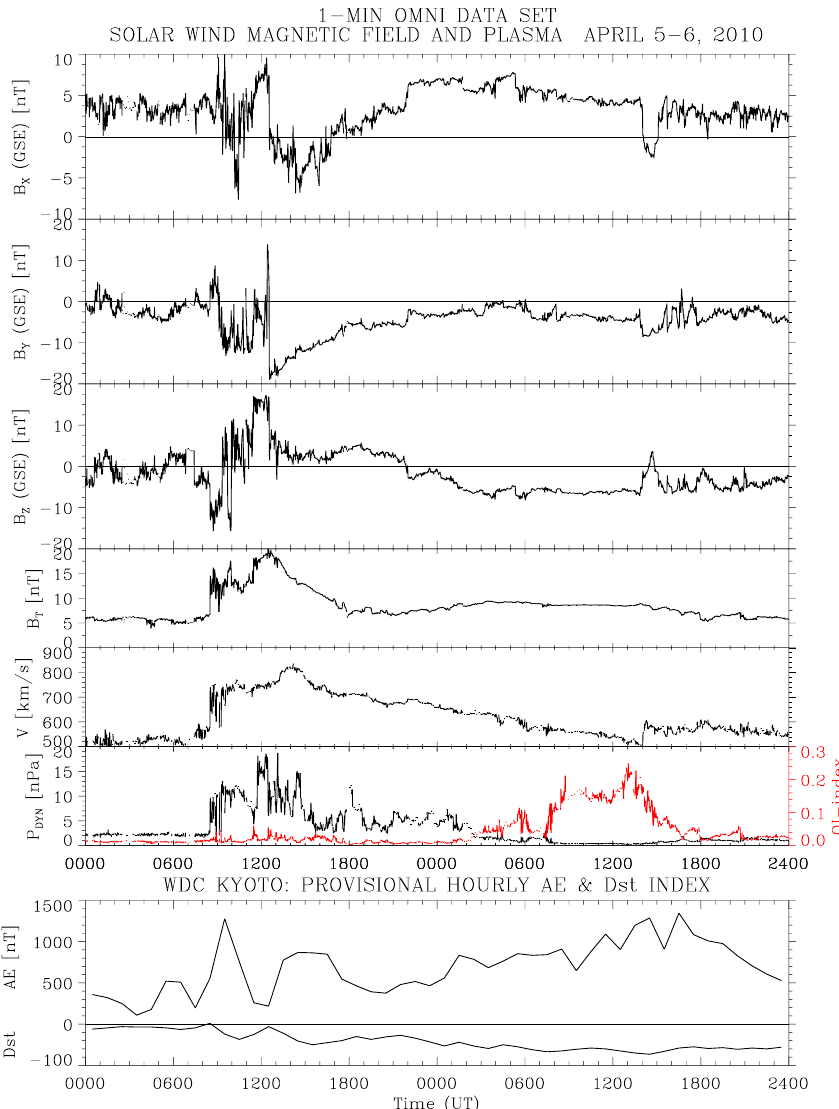
Fig. 2. Solar wind magnetic field and plasma parameters from OMNIWeb data set combining available solar wind monitor data projected to the nose of the Earth’s bow shock. Quasi invariant index is superposed in red line. Provisional hourly values of AE and Dst indices are shown in the bottom